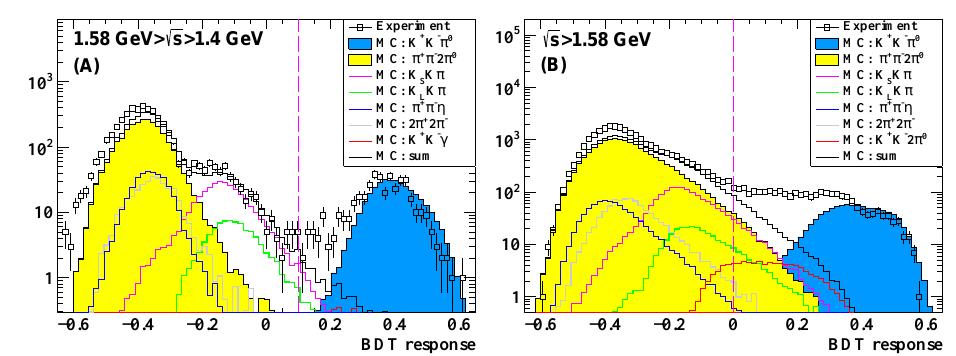
Figure 1. Separation of signal and background events in the range of medium energies (A) and at high energies (B). The dashed lines designate cut lines. The figure also shows the contributions of the main background processes expected from the simulation with normalization to luminosity. Separation of the signal and background events using the BDT response becomes ine ffi cient at high energies.